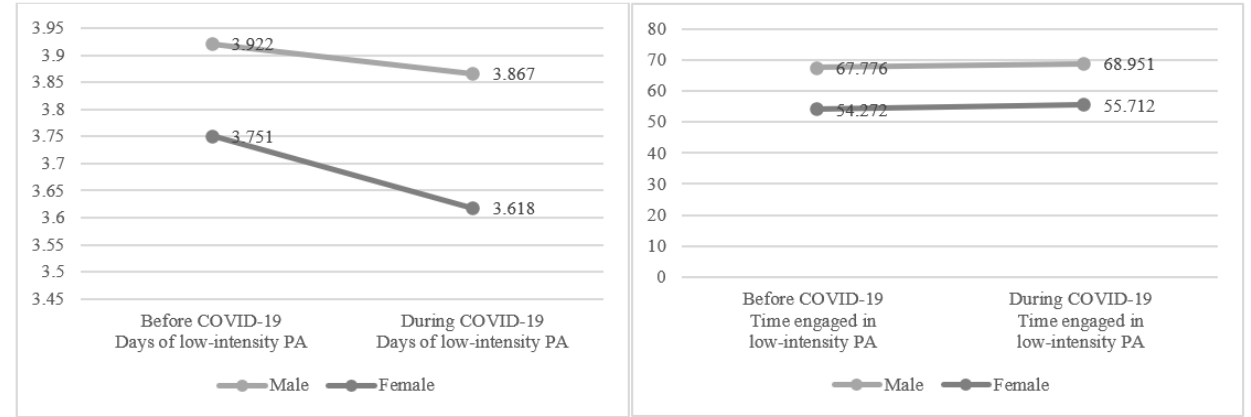
Figure 4. Changes in low-intensity PA by gender before and during COVID-19. Note: Time represents the number of minutes exercised per week.